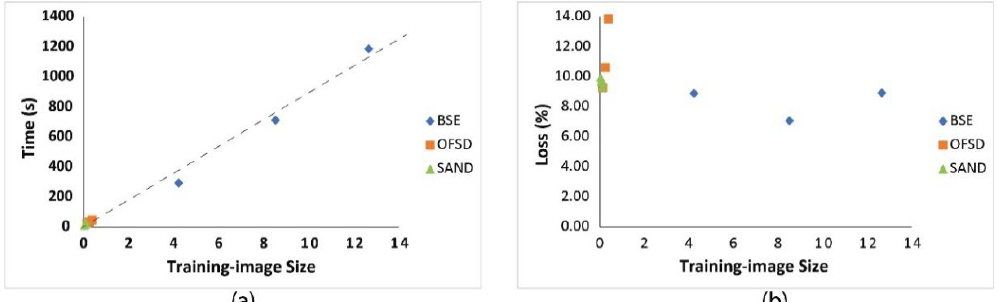
Figure 8. ( a ) Time changes vs. size changes of training images for the nine groups. ( b ) Loss changes vs. size changes of training images for the nine groups.